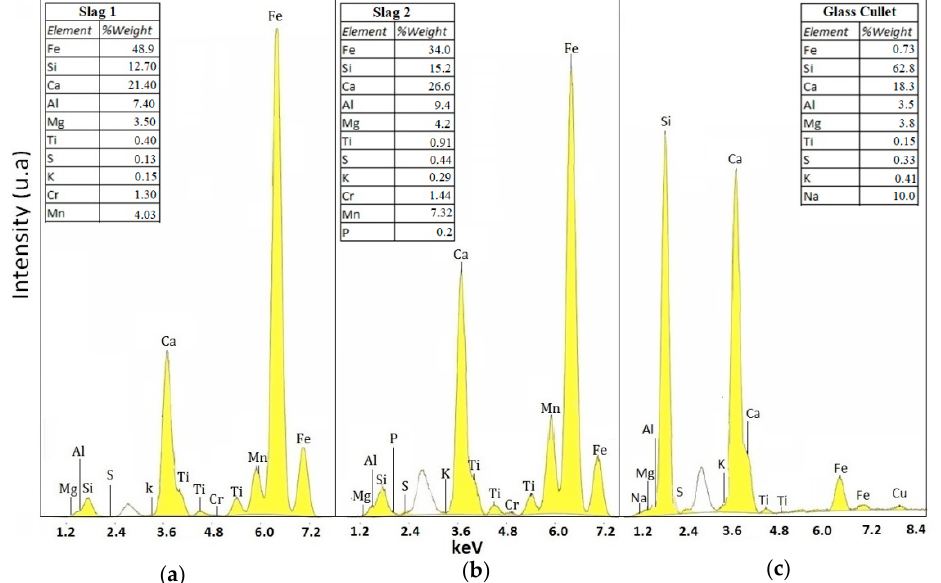
Figure 4. X-ray fluorescence analysis of elemental composition of precursor materials associated with ( a ) slag 1, ( b ) slag 2, and ( c ) glass cullet.